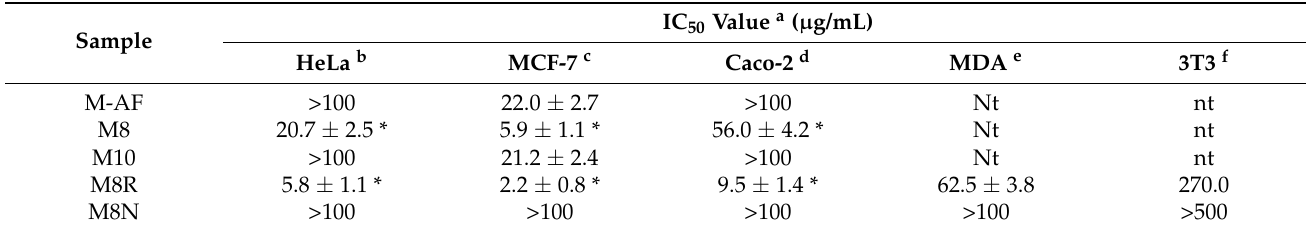
Table 1. IC50 value ( µ g/mL) of the ethyl acetate fraction (AF) of S. spinosum L. extract and the more active fractions obtained from the column chromatography separation in various cancer and non-cancer cell lines.